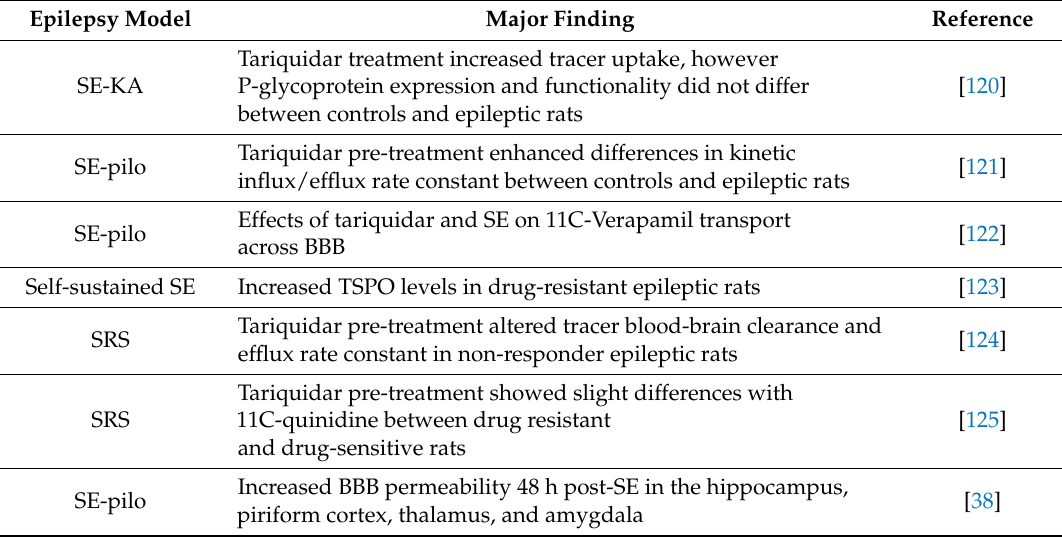
Table 11. List of PET molecular imaging studies for drug resistance and BBB integrity and potential biomarkers for